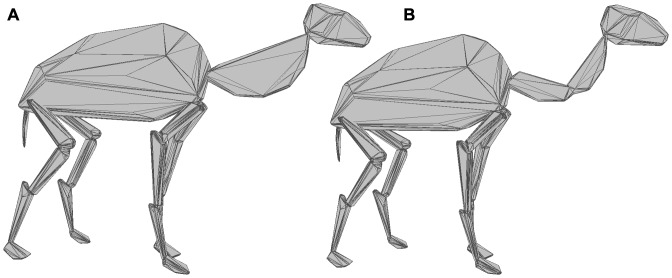
Effect of subdividing neck of C. dromedaries on convex hull volume.A, illustrates extent of neck convex hull without subdivision due to curvature of cervical series; B, tighter fit of convex hulls when divided into two parts.